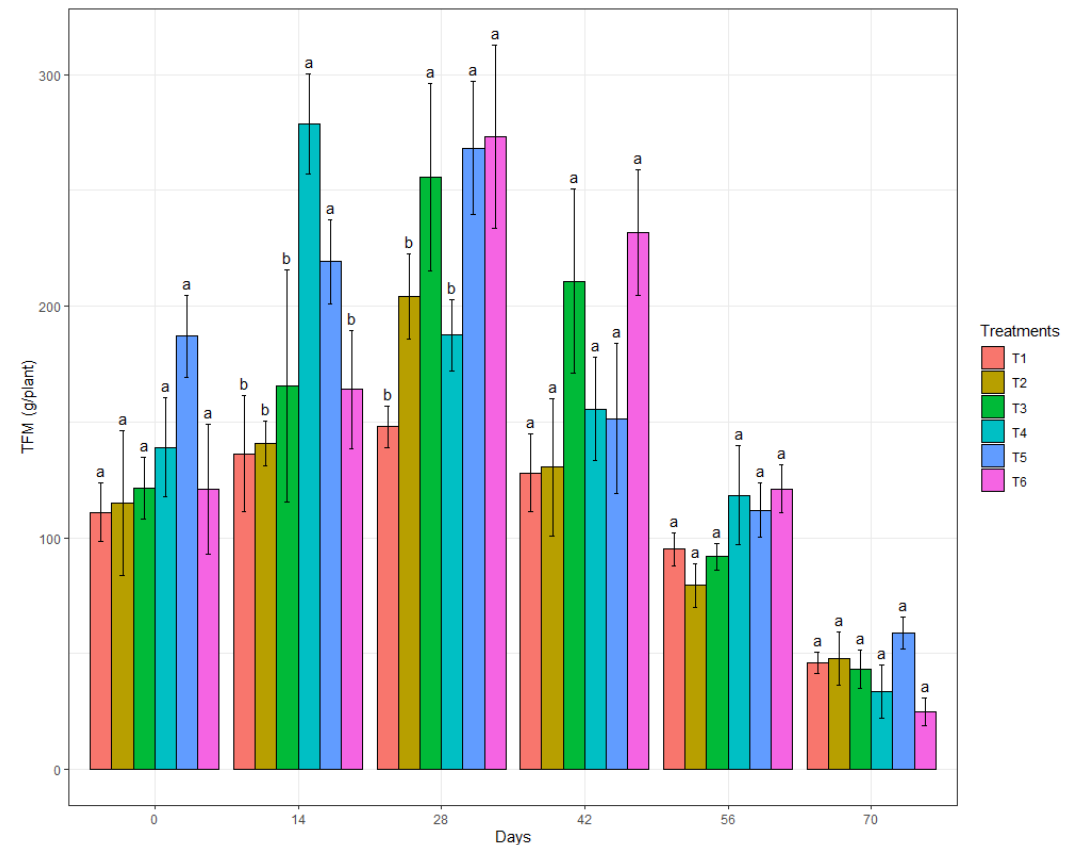
Figure 5. Mean TFM of the treatments (T1: water; T2: chemical control; T3: biological control; T4: B.BV10 1 g/L; T5: B.BV10 2 g/L; and T6: B.BV10 4 g/L) at each time of evaluation. Means in each day followed by the same letter did not differ significantly from each other by the Scott – Knott test ( p < 0.05).